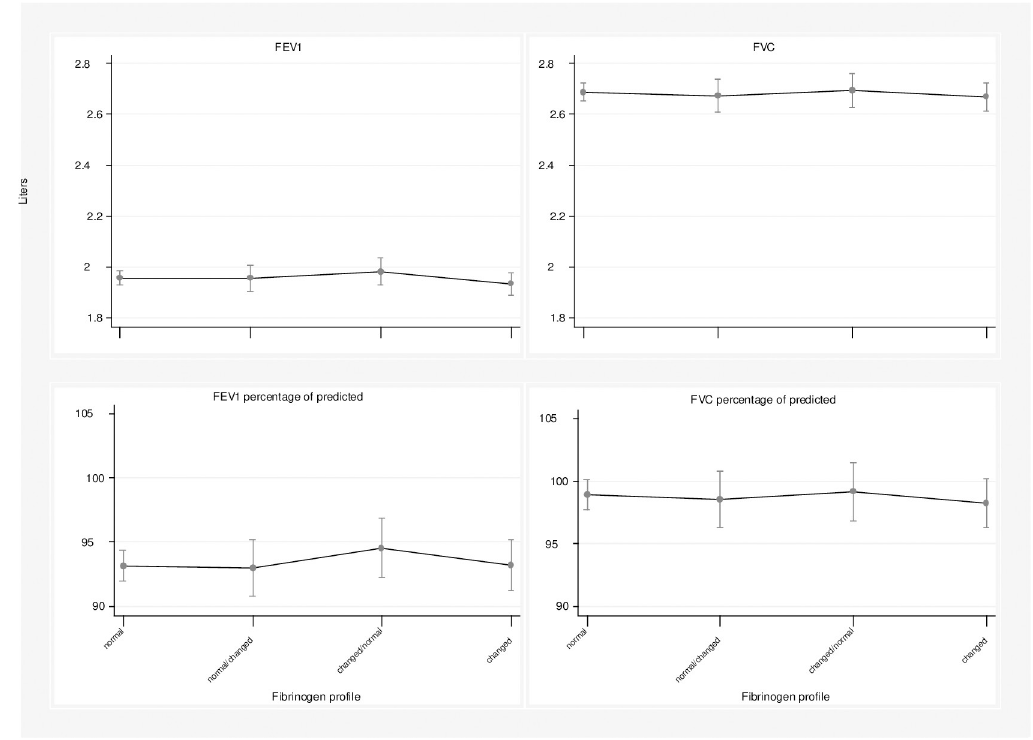
Fig 3. Linear predictions for the FEV 1 (L), FVC (L), FEV 1 percentage of predicted and FVC percentage of predicted in women, The English Longitudinal Study of Ageing, England, 2004 to 2013.